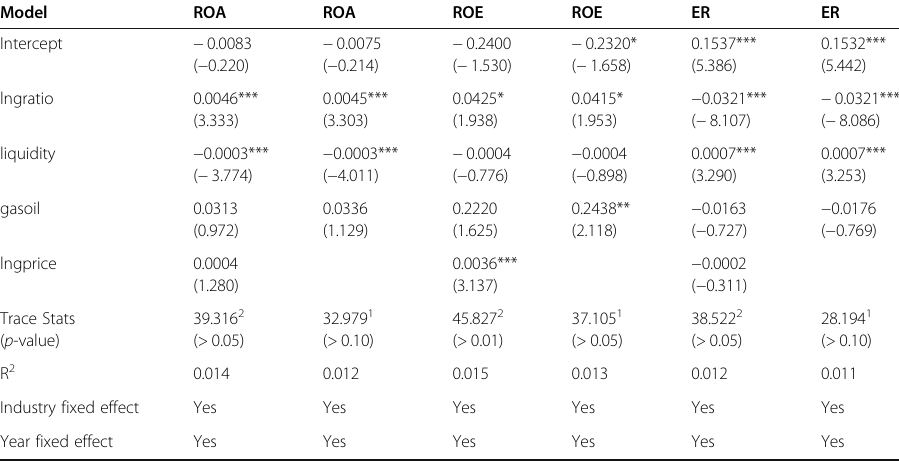
Table 3 Financial performance of 34 shipping firms that extended into LNG carrier